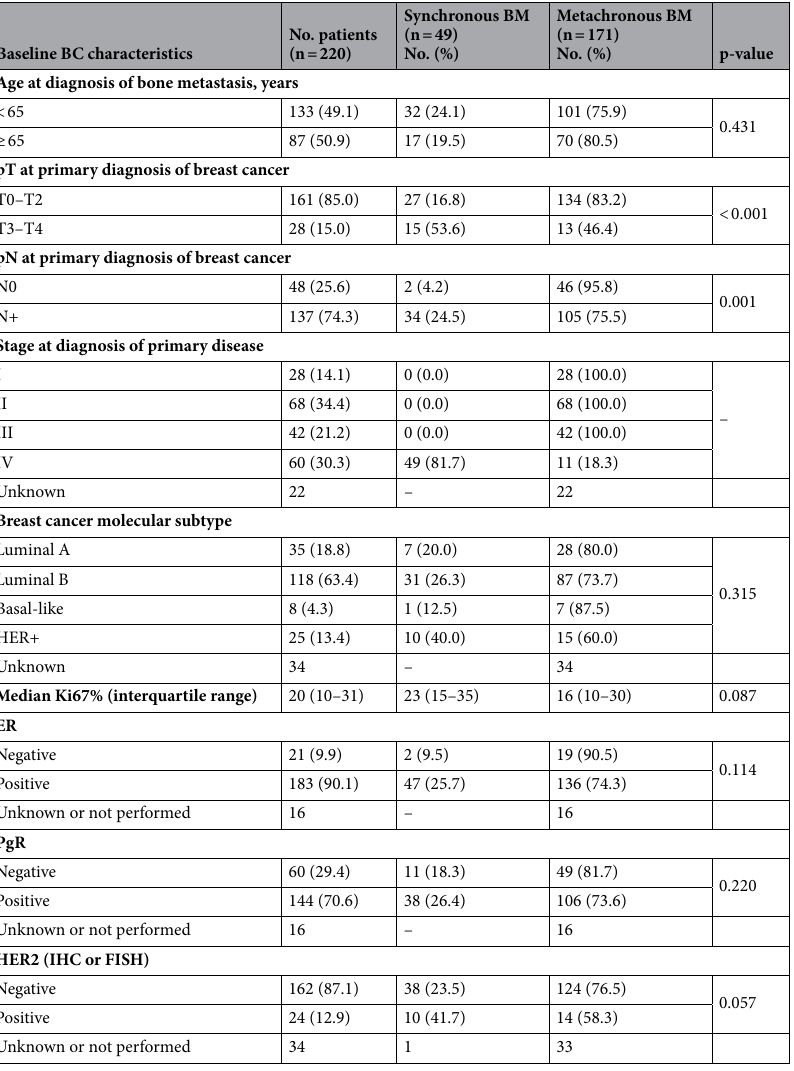
Table 4. Baseline patient characteristics in relation to synchronous or metachronous metastases. BM bone metastasis, pT primary tumour, pN pathological lymph node, ER oestrogen receptor, PgR progesterone receptor, IHC immunohistochemistry, FISH fluorescence in situ